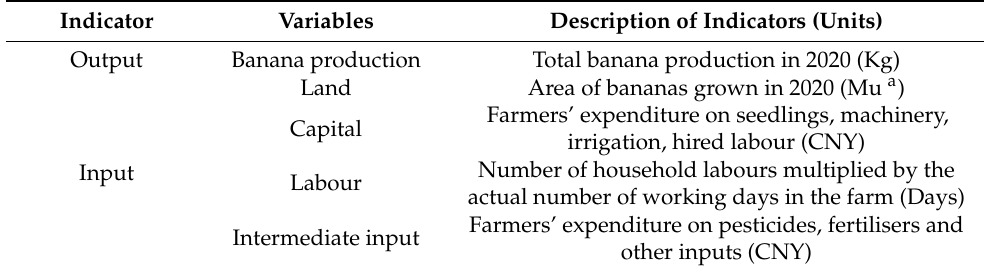
Table 1. Description of input and output indicators. Indicator Variables Description of Indicators (Units) Output Banana production Total banana production in 2020 (Kg) Land Farmers’ expenditure on seedlings, machinery, Capital irrigation, hired labour (CNY) Number of household labours multiplied by the Input Labour actual number of working days in the farm (Days) Farmers’ expenditure on pesticides, fertilisers and Intermediate input other inputs